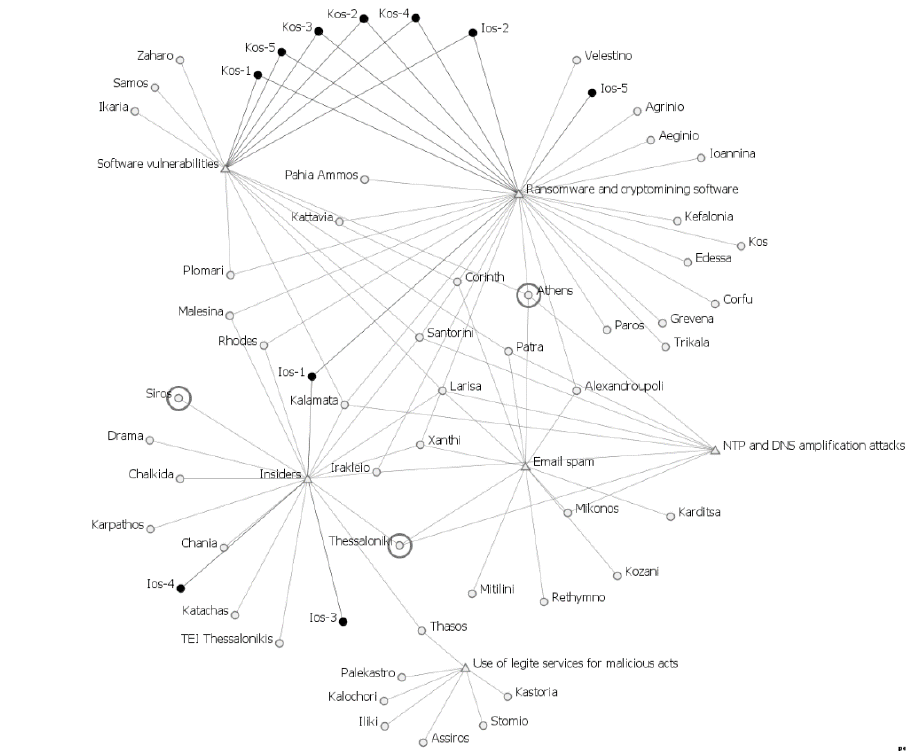
Figure 7. Affiliation network with new